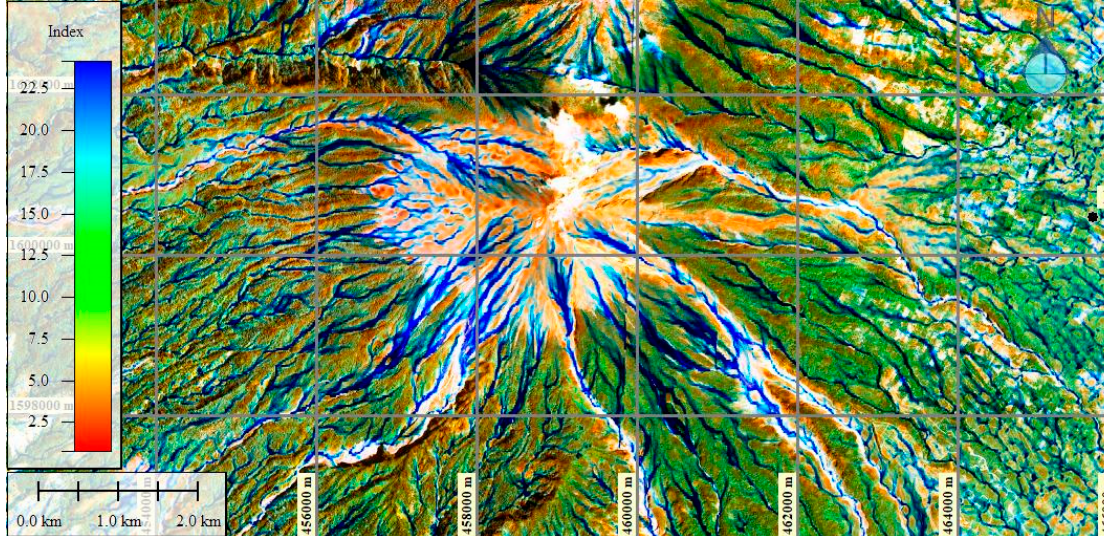
Figure 10. Topographic wetness index (TWI) calculated in SAGA GIS. Higher values of TWI (tendency to blue color) represent drainage depressions and lower values (tendency to red color) represent crests and ridges.